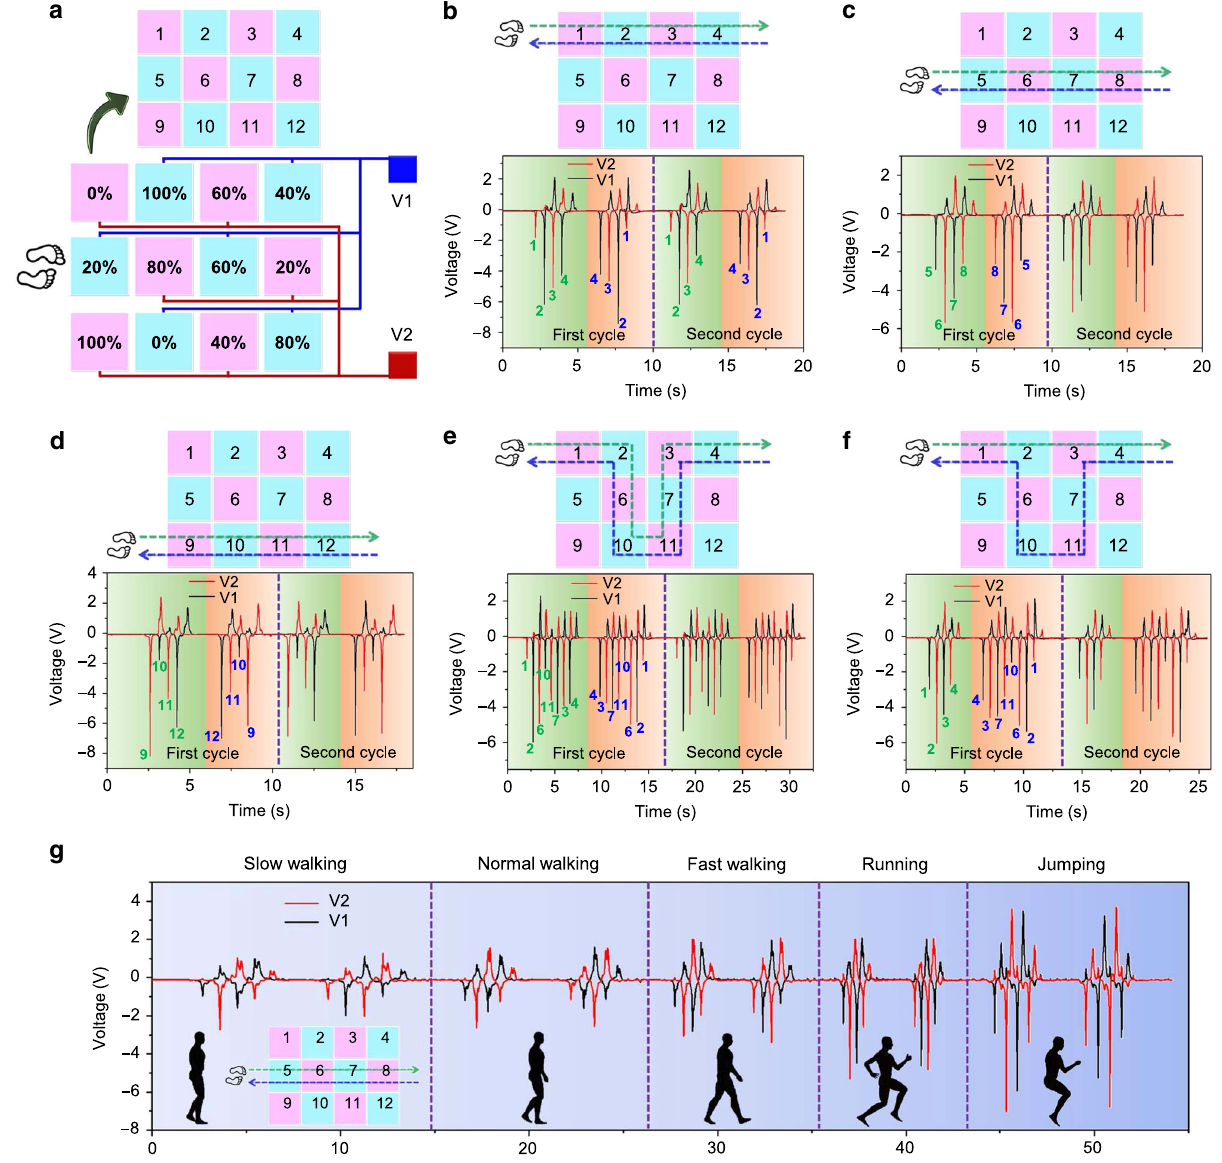
Fig. 4 DLES-mat array for position/trajectory detection and activity monitoring. a The schematic diagram of the constructed 3 × 4 DLES-mat array with two output electrodes. The 12 digits (1 – 12) indicate the numbering for each DLES-mat in the corresponding position. b – f The corresponding generated voltages by the indicated two cycles of forward – backward walking trajectories on the DLES-mat array. Based on the relative signal magnitudes on the two electrodes, walking patterns on the DLES-mat array can be determined for walking trajectory detection. g Activity monitoring for slow walking, normal walking, fast walking, running, and jumping, according to the output signal magnitudes and and right foot stepping fi rst in the second cycle) along different trajectories are conducted to verify the position sensing capability of the DLES-mat array, as shown in Fig. 4b – f. According to the relative magnitude trend obtained in the previous study, voltage pulse with higher peak-to-peak magnitude is generated from the DLES-mat with a higher electrode coverage rate. For example, in Fig. 4b, the person is walking on the fi rst row of the DLES-mat array, with Mat 1 (0%) and Mat 3 (60%) connected to electrode 2 (E2) and Mat 2 (100%) and Mat 4 (40%) connected to electrode 1 (E1). From the output voltages in both cycles, a clear trend can be observed in the voltage magnitudes on both electrodes. For walking forward from Mat 1 to 4, an output voltage pulse with the lowest magnitude is fi rst generated on E2 (0%), and then an forward – backward cycles (left foot stepping fi rst in the fi rst cycle